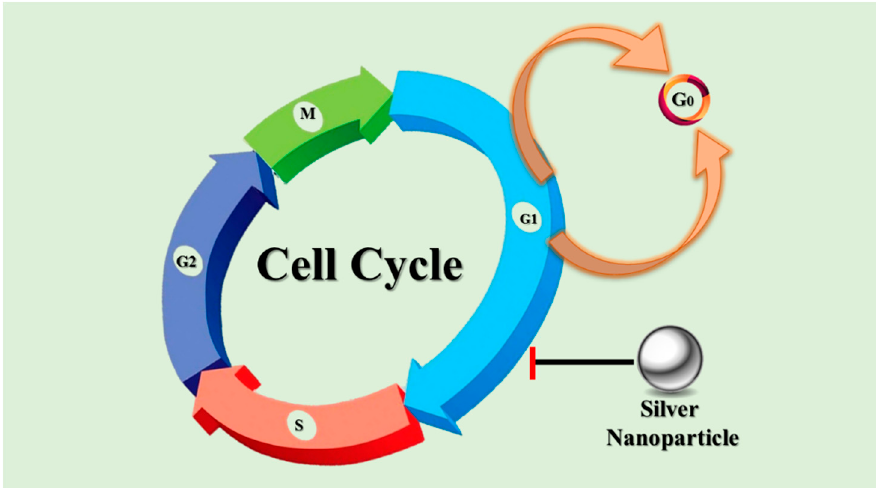
Figure 7. Schematic diagram of cell cycle arrest by AgNPs.